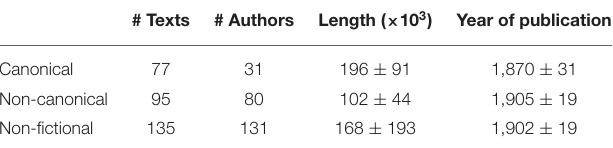
TABLE 1 | Number of texts, number of authors, mean text length (number of tokens), and mean year of publication ( ± SD) for the different text categories of the JEFP